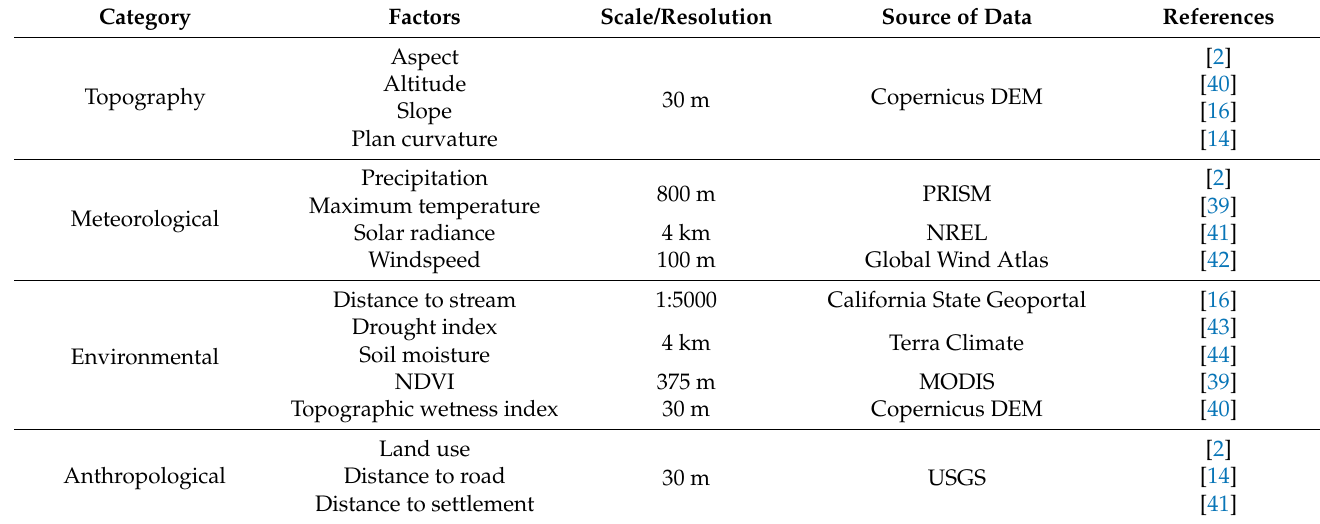
Table 3. The list and description of wildfire conditioning